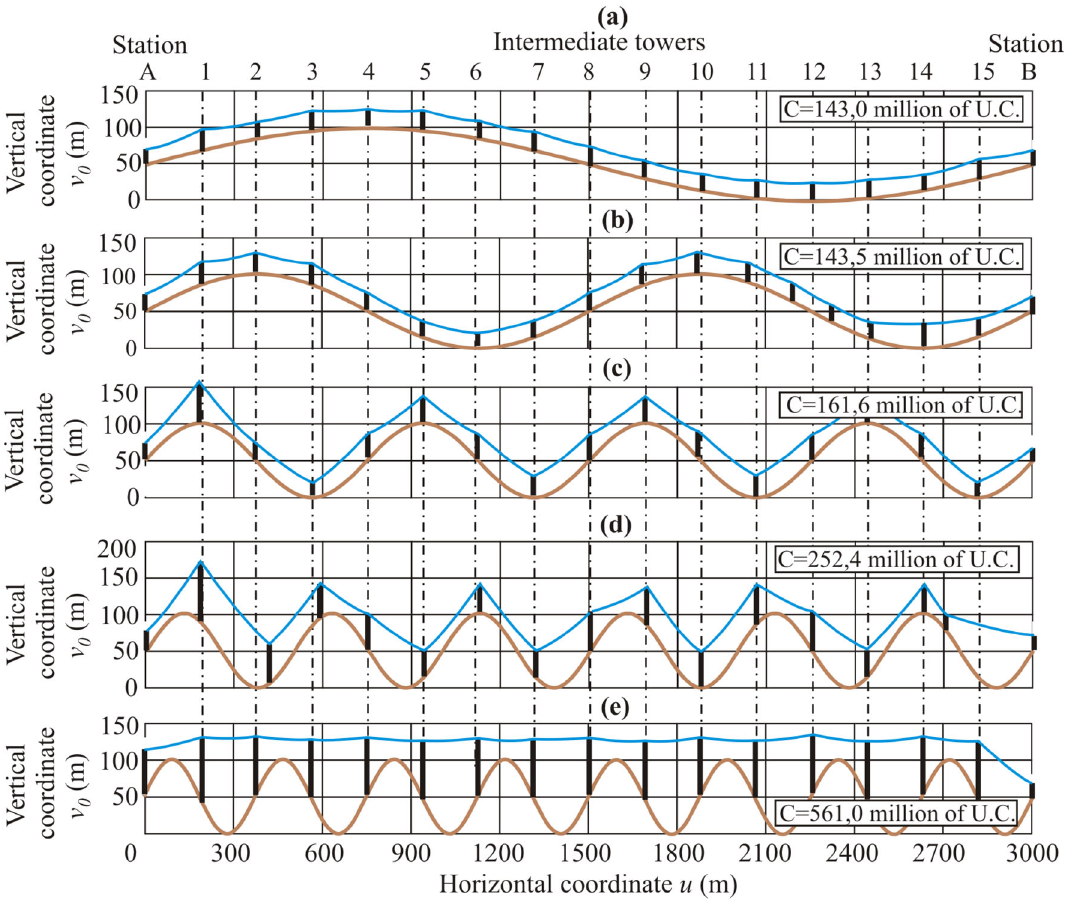
Fig. 6 The influence of the terrain diversity on the optimal arrangement and height of the intermediate towers of the aerial ropeway: ( a ) when the number of the half-waves is n = 2; ( b ) n = 4; ( c ) n = 8; ( d ) n = 12; ( e ) n =